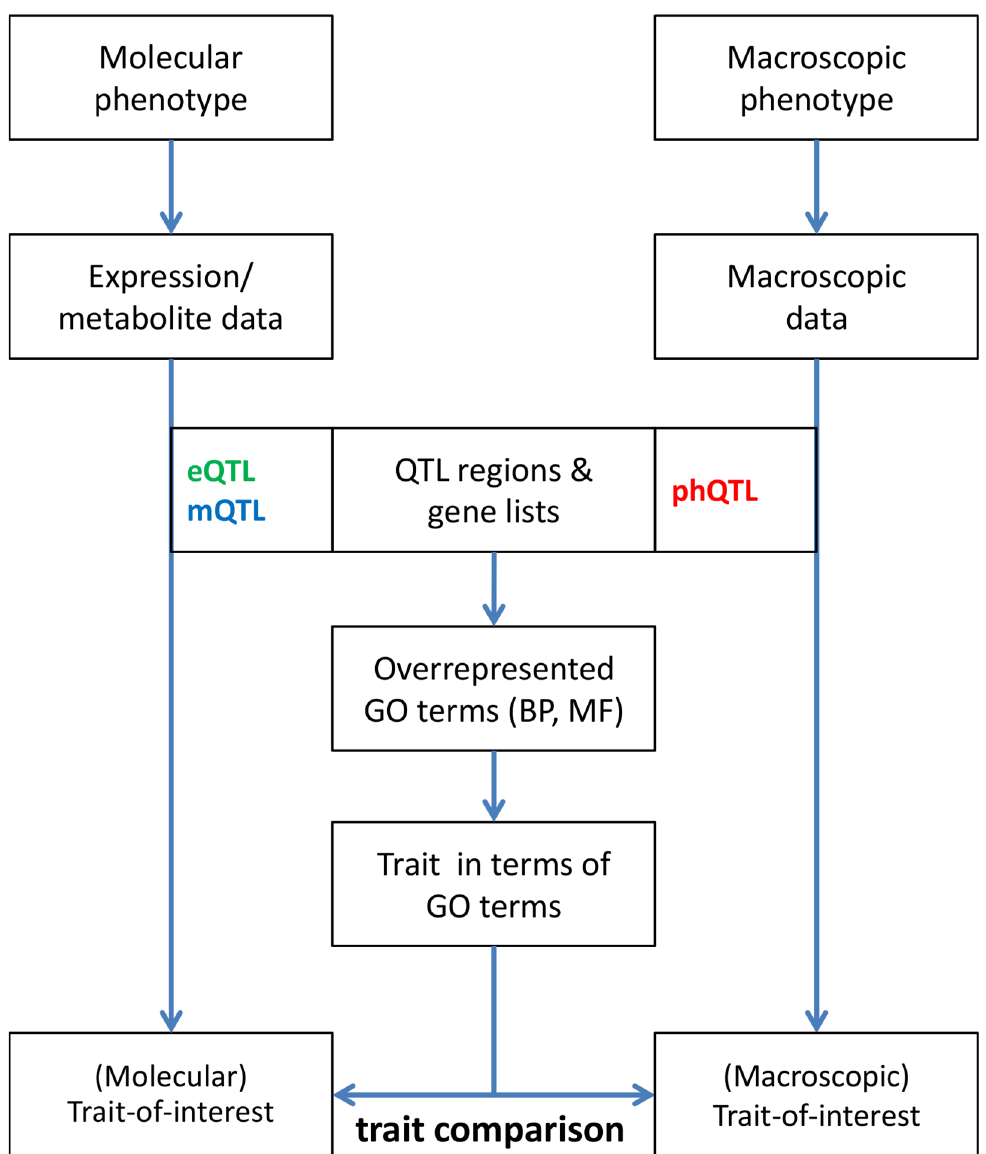
Fig 1. Flowchart of comparative trait analysis. Any trait of interest that is associatedwith multiple QTL regions, be it molecularor macroscopicin nature, is convertedto a list of (overrepresented) GO terms for both biologicalprocesses (BP) and molecularfunctions (MF). The genelists in the respective QTL regions are used for the predictionof GO terms and subsequent overrepresentation analysisrelative to the occurrenceof GO terms in the whole genome.The resultinglists of overrepresented GO terms enablecomparing different traits for (dis) similarity. The formal specification of traits in GO terms allows comparisonof any trait to any other trait. The figure emphasizesthe comparisonof molecularwith macroscopic